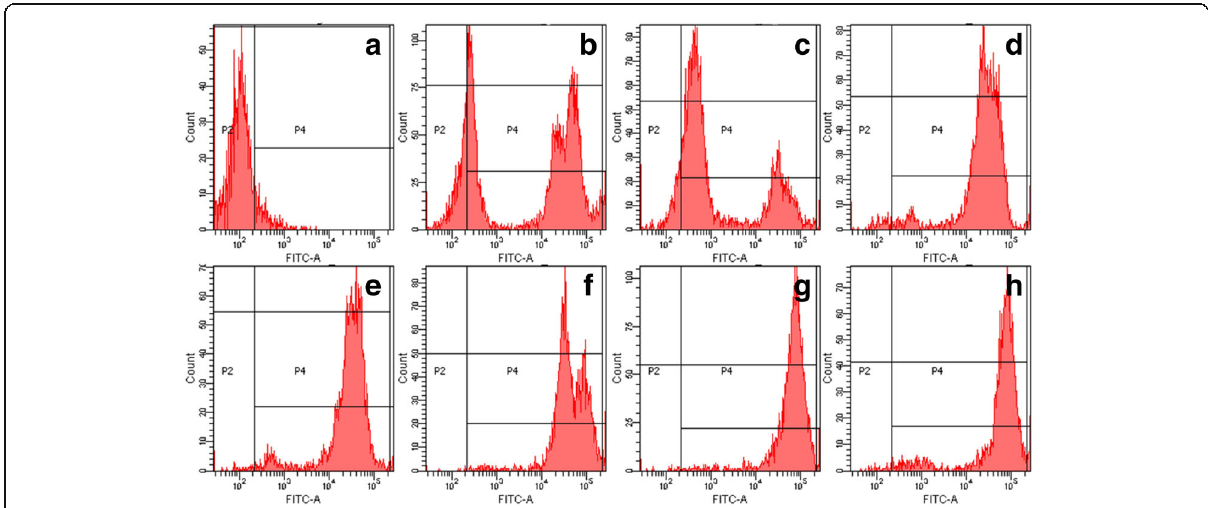
Fig. 3 Respiratory burst of neutrophils. Hydrogen peroxide generation in neutrophils measured by dihydrorhodamine oxidation (DHR) analysis with Flow Cytometry. a the patient. b the patient ’ s sister. c the patient ’ s mother. d the patient ’ s father. e the patient ’ s paternal aunt. f the patient ’ s maternal uncle. g the patient ’ s paternal grandmother. h the patient ’ s maternal grandfather